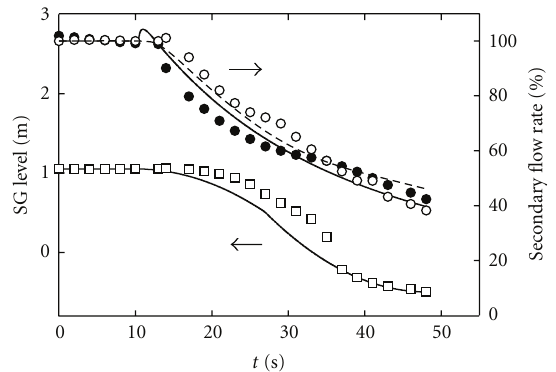
Figure 7: Event 1. Evolution of the steam-generator water level, the feedwater flow (full circles and solid curve), and the steam flow (empty circles and dashed curve).